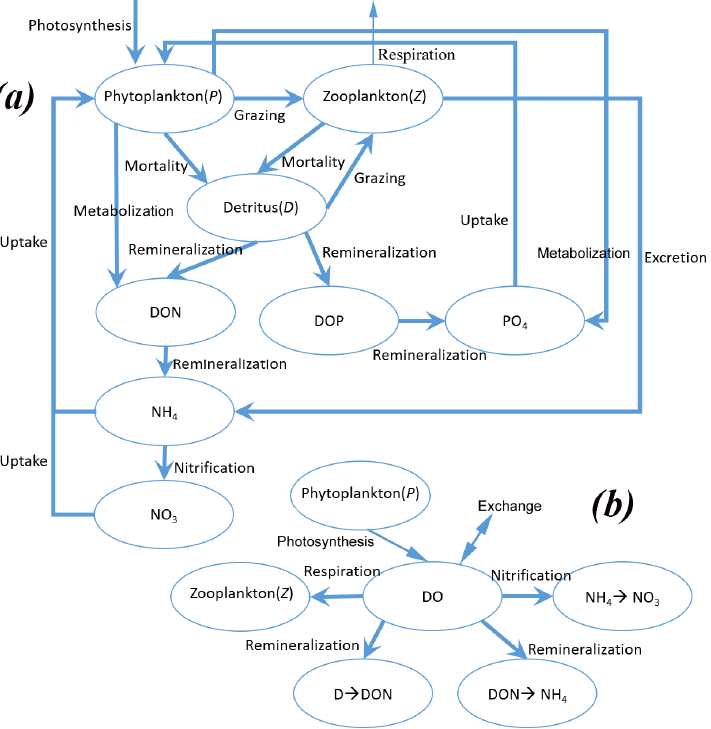
Figure 1. The schematic structure of the water quality model ( a ) and the budget of DO concentration in the water quality model ( b ). Table 1. Values and units of the parameters of the water quality